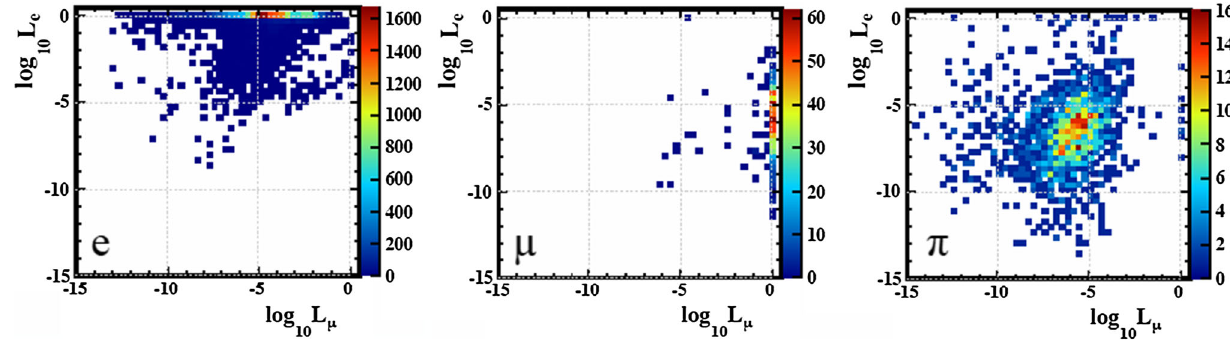
Fig. 11 e-likelihood and μ -likelihood of charged particles with E > 20GeV in eeH event